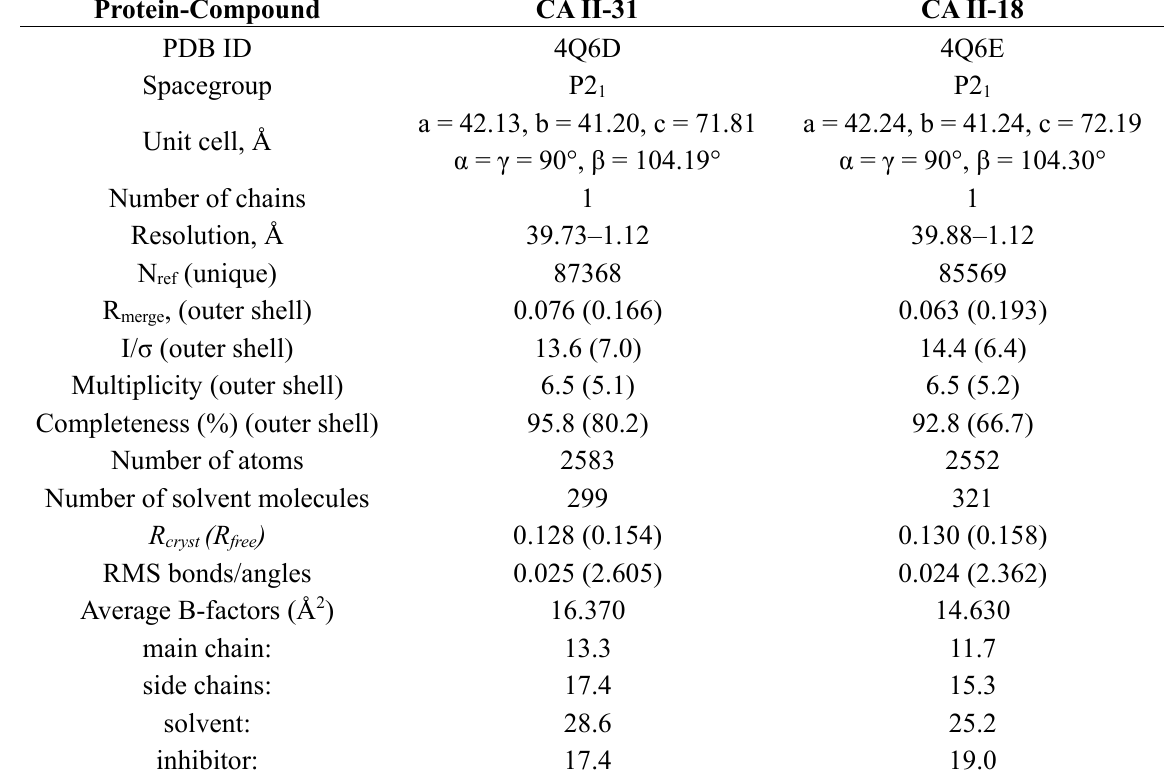
Table 2. X-ray crystallographic data collection and refinement statistics. All datasets were collected at 100 K, test set size was